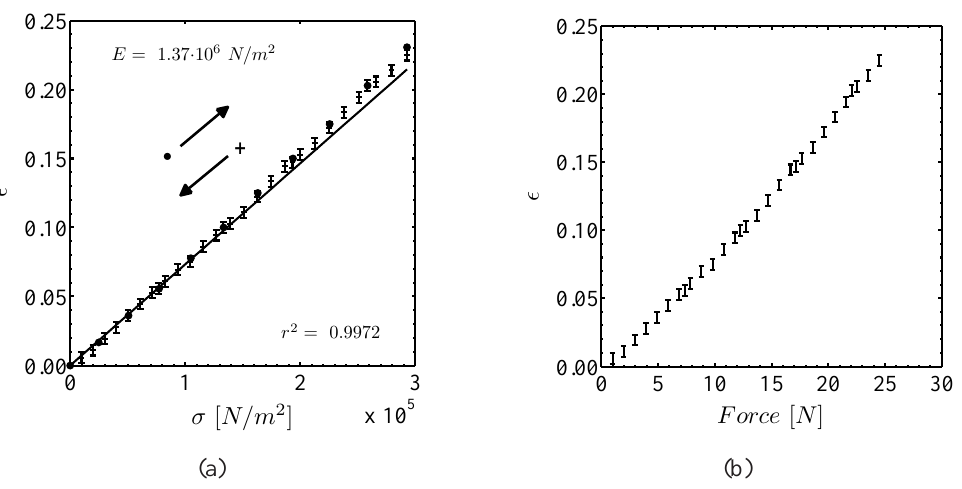
Figure 4. ( a ) Stress-strain relation for the tensile specimen, ( b ) force-strain relation for the tensile